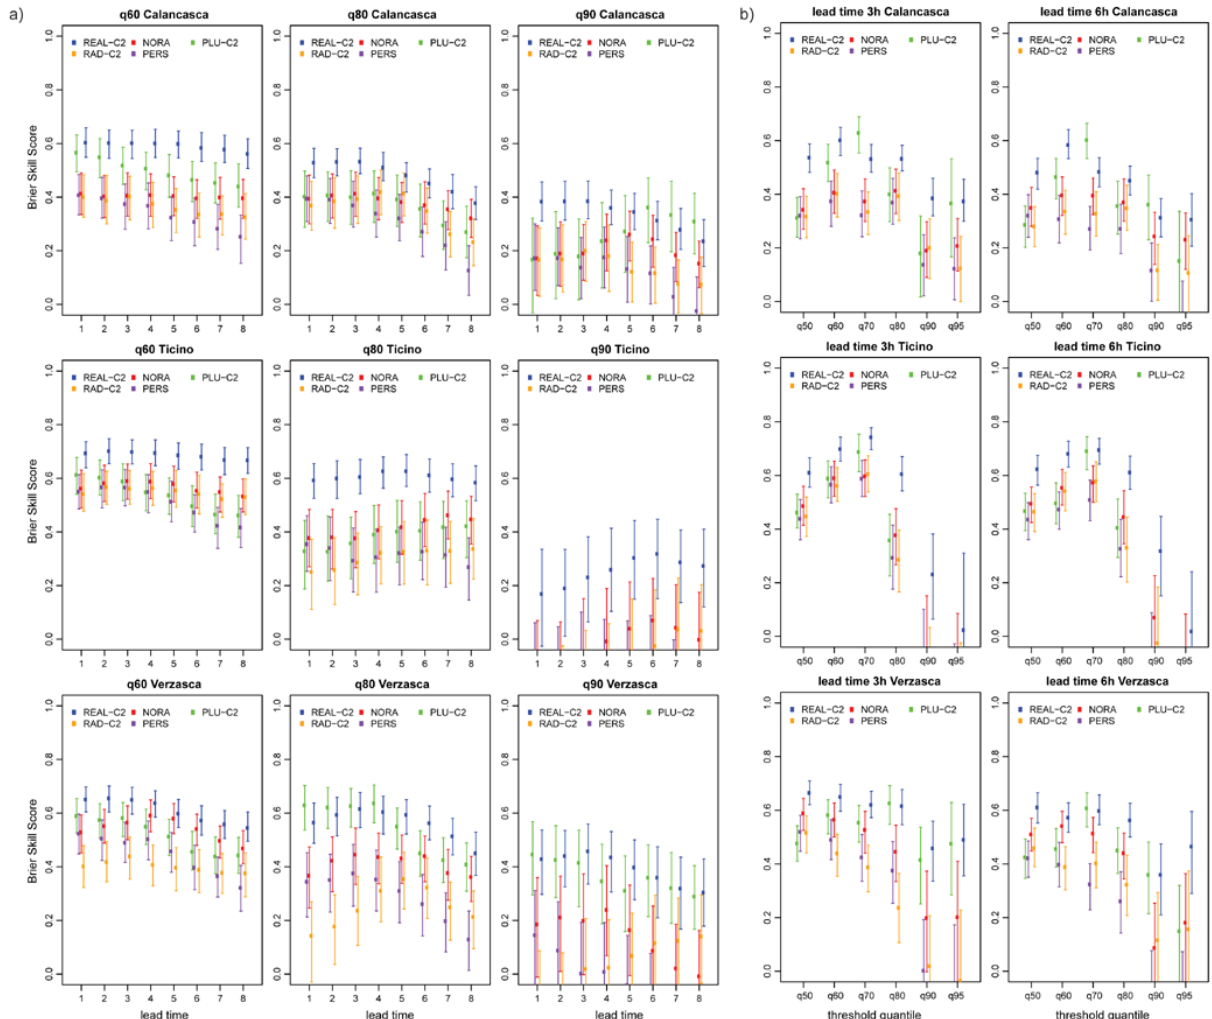
Fig. 5. (a) Brier skill score (BSS) according to lead time for the threshold quantile q60, q80 and q90. (b) BSS according to the threshold quantiles q50 to q95 for 3 and 6h lead time. Error bars indicate the 95% confidence limits around the estimated BSS value. Positive BSS values indicate an improvement in the forecast over the reference forecast, which in this case is the sample